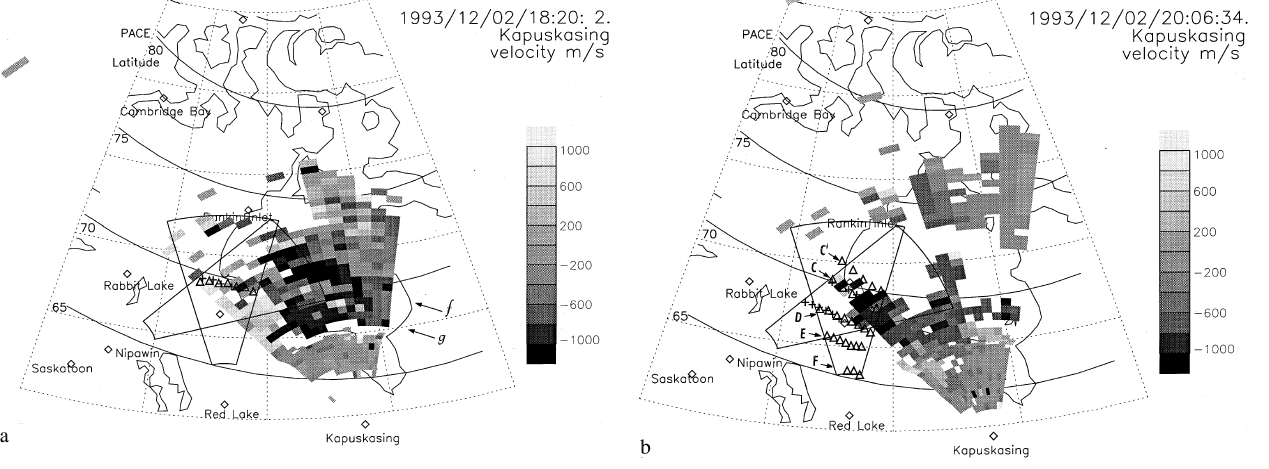
Fig.16a, b. The Kapuskasing SuperDARN radar maps of line-of- sight velocities. a Flow channel events (FCEs) is associated with the BARS E-region backscatter bands f and g . Symbols in the BARS field